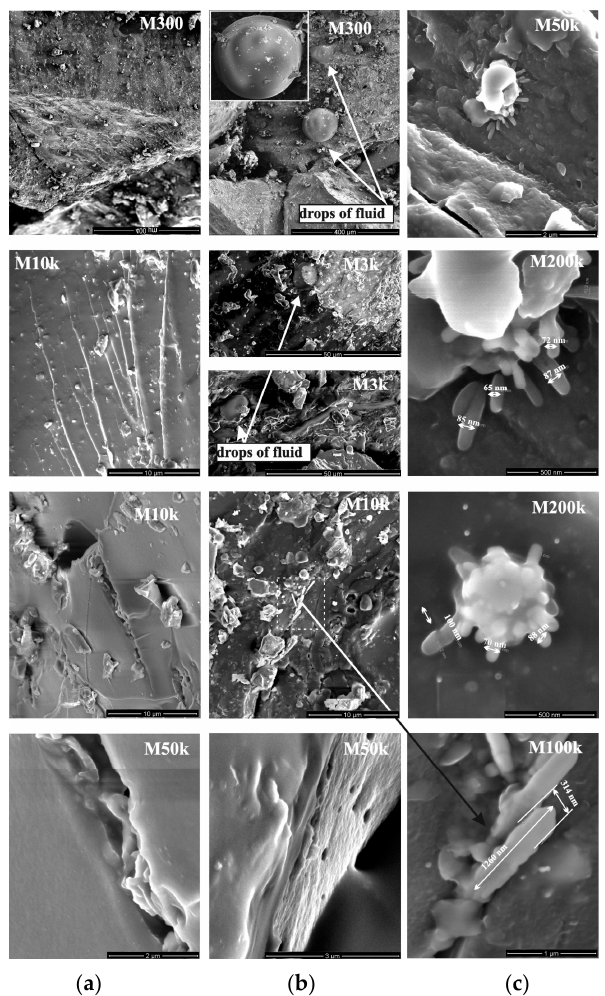
Figure 7. The SEM images of swollen grains from plastic layer of fresh ( a ) and thawed ( b ) coals along with the nano-objects on the surface on swollen grains of thawed coal ( c ).